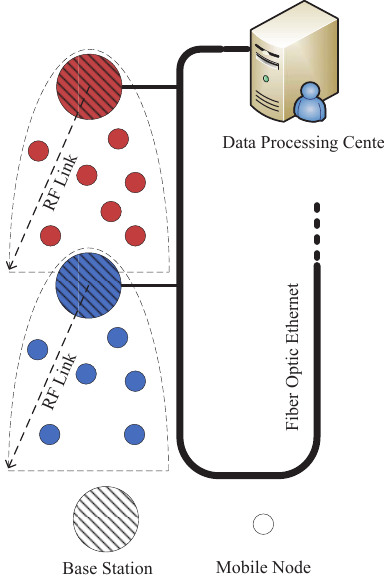
Figure 2. System